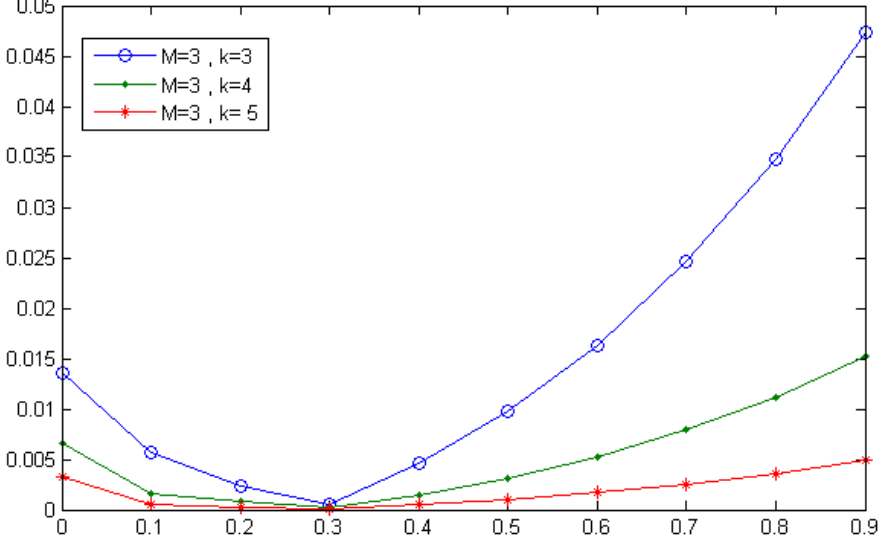
Figure 2. Absolute error of y 1 ( t ) for M = 3 and k = 3,4,5 (Example 1).